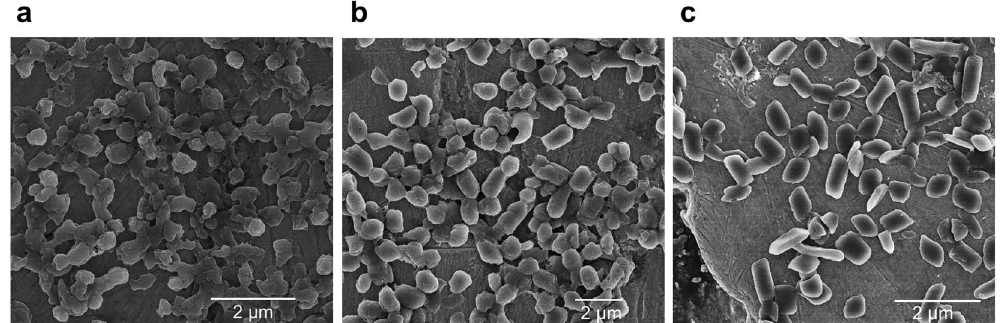
Figure 3. Comparison of Cry3Aa * -lipA particles produced in Bt and E. coil . ( a ) SEM of Cry3Aa * -lipA particles produced in E. coli at 11,000 × magnification. ( b ) SEM of Cry3Aa * -lipA particles produced in Bt at 6,000 × magnification. ( c ) SEM of Cry3Aa particles produced in Bt at 2,500 × magnification.